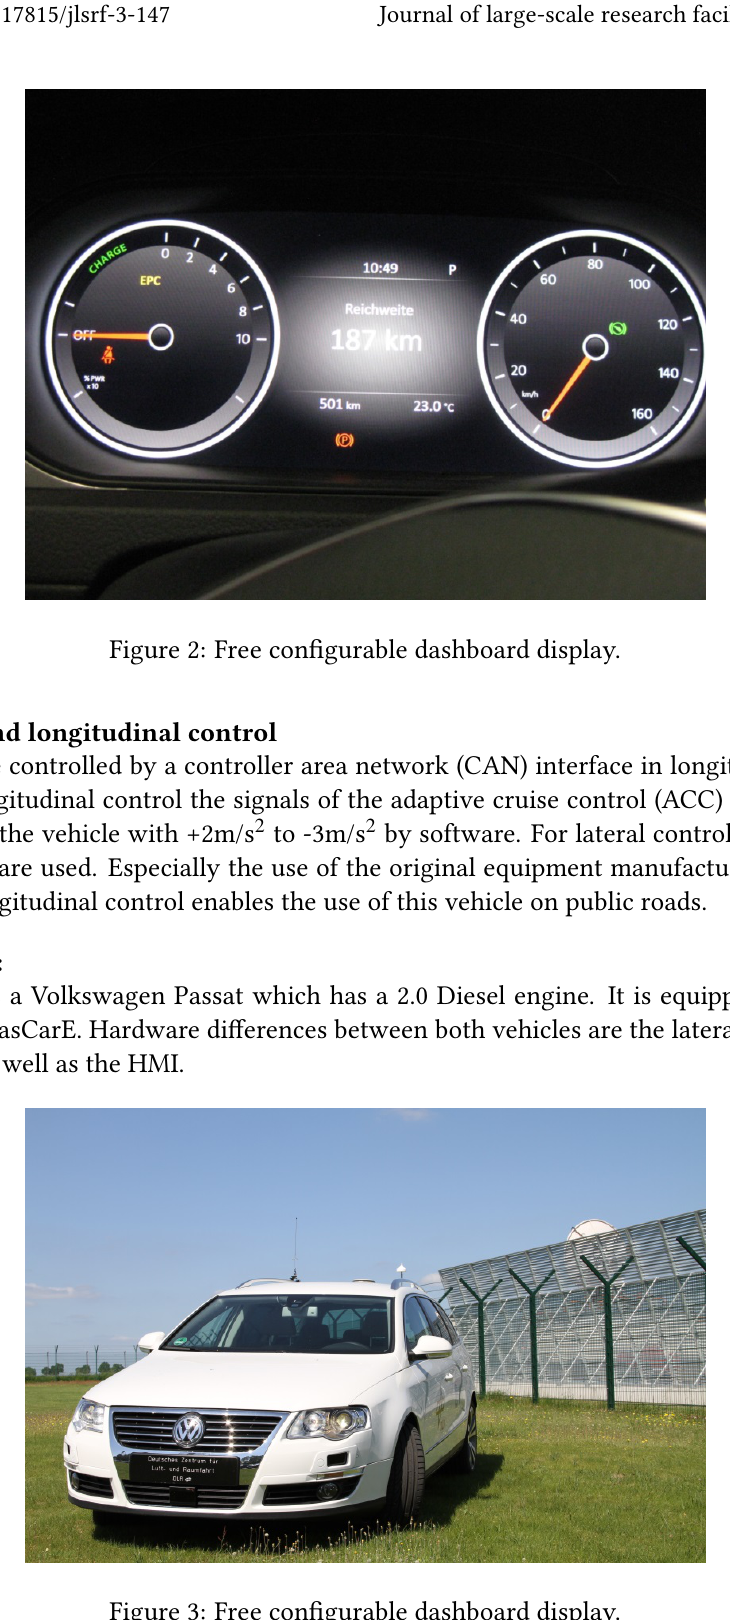
Figure 3: Free configurable dashboard